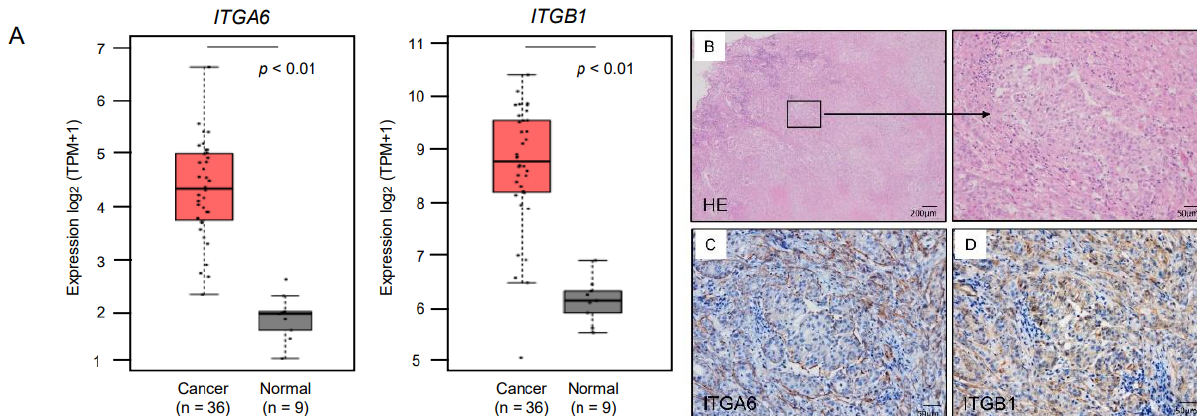
Figure 4. Expression of ITGA6 and ITGB1 in ICC. ( A ) Expression levels of ITGA6 and ITGB1 in ICC tissues and normal tissues obtained from TCGA-CHOL based on the GEPIA2 platform. ( B ) H&E-stained sections of human ICC tissue. Areas in the boxed region at the left are shown magnified at right. ( C , D ) Representative images of tissues immunostained for ITGA6 and ITGB1. ITGA6 stained positive in the membranes of cancer cells in a clinical sample (original magnification × 100). ITGB1 stained positive in the membranes, cytoplasm and a part of the nuclei of cancer cells in a clinical sample (original magnification × 100).